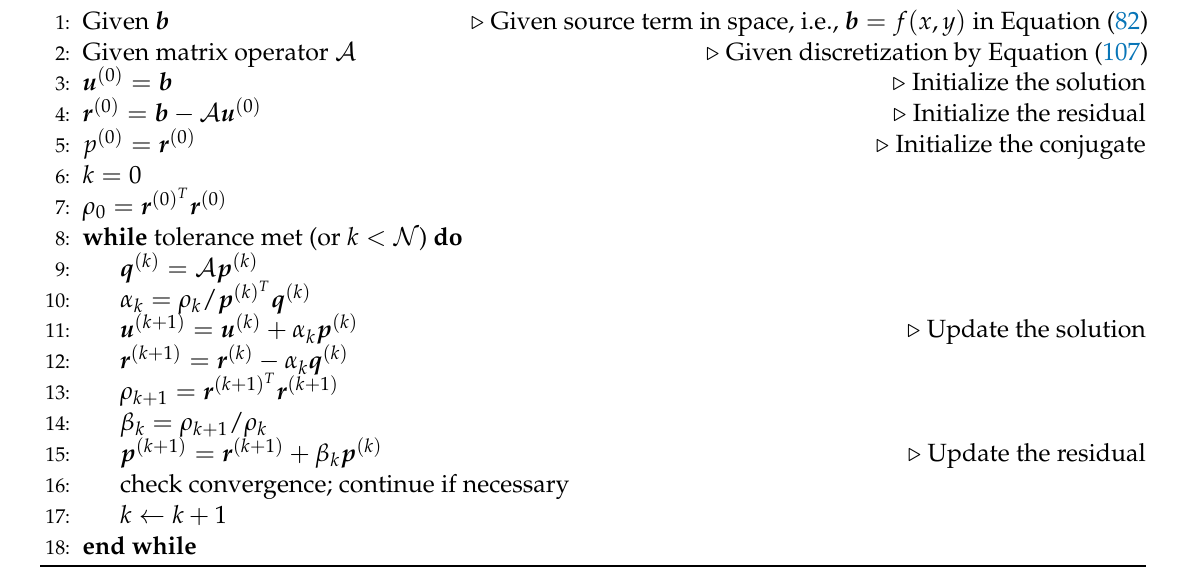
Algorithm 4 Conjugate gradient algorithm